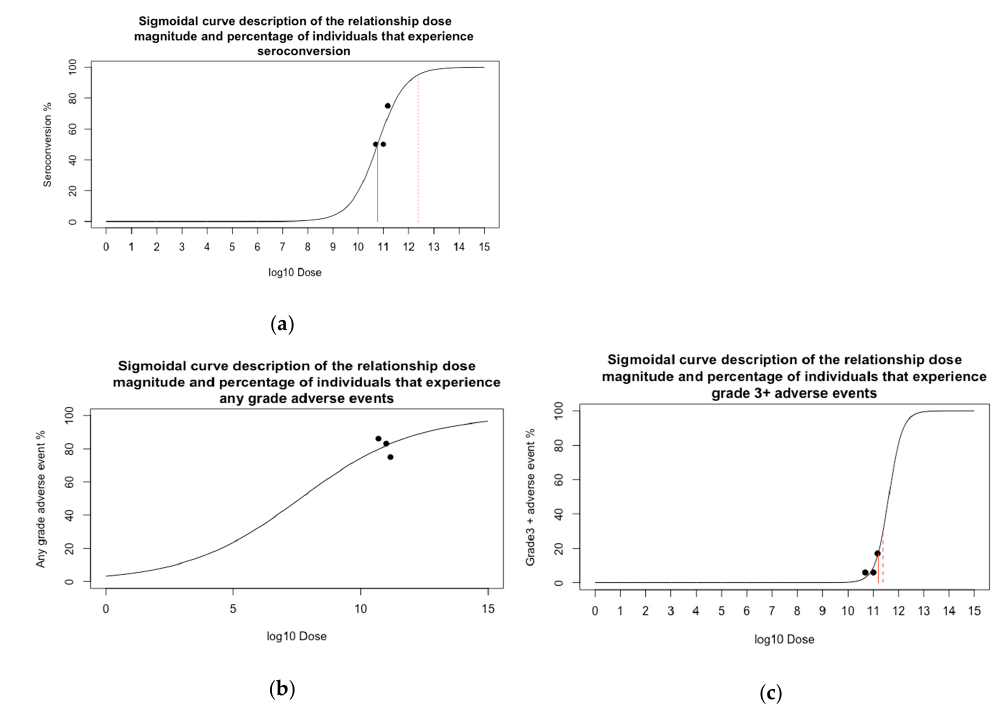
Figure 2. The three curves displaying the relationship between dose and ( a ) percentage of vaccinated individuals predicted to seroconvert, ( b ) percentage of vaccinated individuals predicted to experience any grade adverse events and ( c ) percentage of vaccinated individuals predicted to experience grade 3+ adverse events. The curves are sigmoid curves calibrated to data. Black dots represent the data the curves were calibrated to. In ( a ) the solid and dashed red lines show respectively the doses for which 50% and 90% of individuals are predicted to seroconvert. In ( c ) the solid and dashed red lines show respectively the doses for which 17% and 30% of individuals are predicted to experience grade 3+ adverse events. We note that the percentage of individuals experiencing any grade adverse events in ( b ) qualitatively decreased with increasing dose, whereas the model curve was increasing. This decreasing trend could be explained by the expected stochasticity in the data, hence the sigmoid model did not seem unreasonable (Supplementary